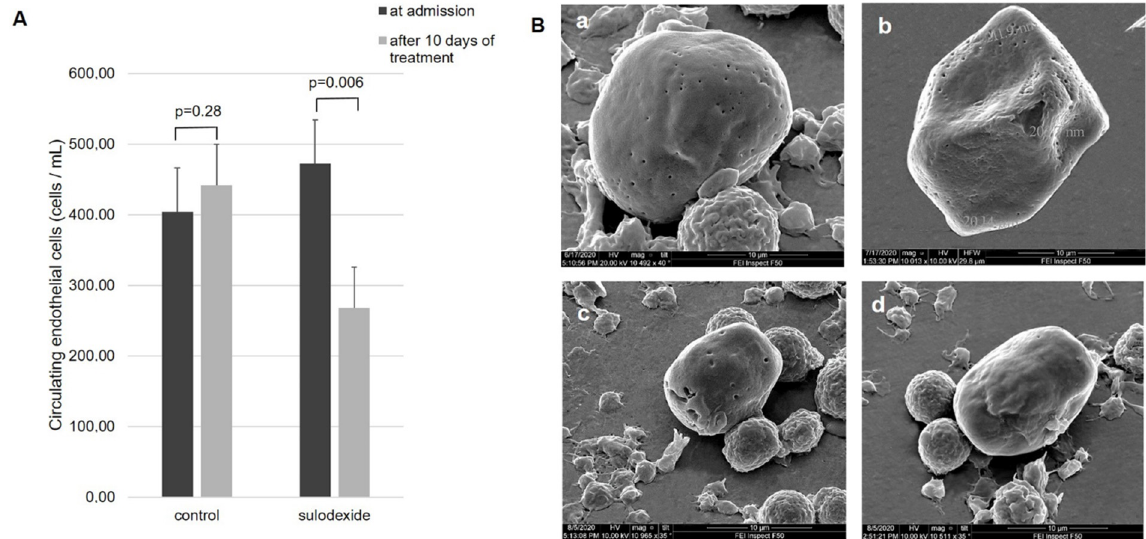
Figure 1. ( A ): Effect of sulodexide on CEC level. ( B ): CEC in the blood of patients on admission with membrane fenestration typical of COVID-19 ( a , c ). After routine treatment of control patients, the quantity of such CEC did not decrease. Moreover, their morphological features (characterized by a large number of membrane fenestrations with the size of the viral capsid) were retained ( b ). The addition of sulodexide to the standard treatment significantly decreased the quantity of CEC in blood specimens and decreased the number of virus-produced fenestrations to the extent of their complete disappearance ( d ). Magnification ×10.000.